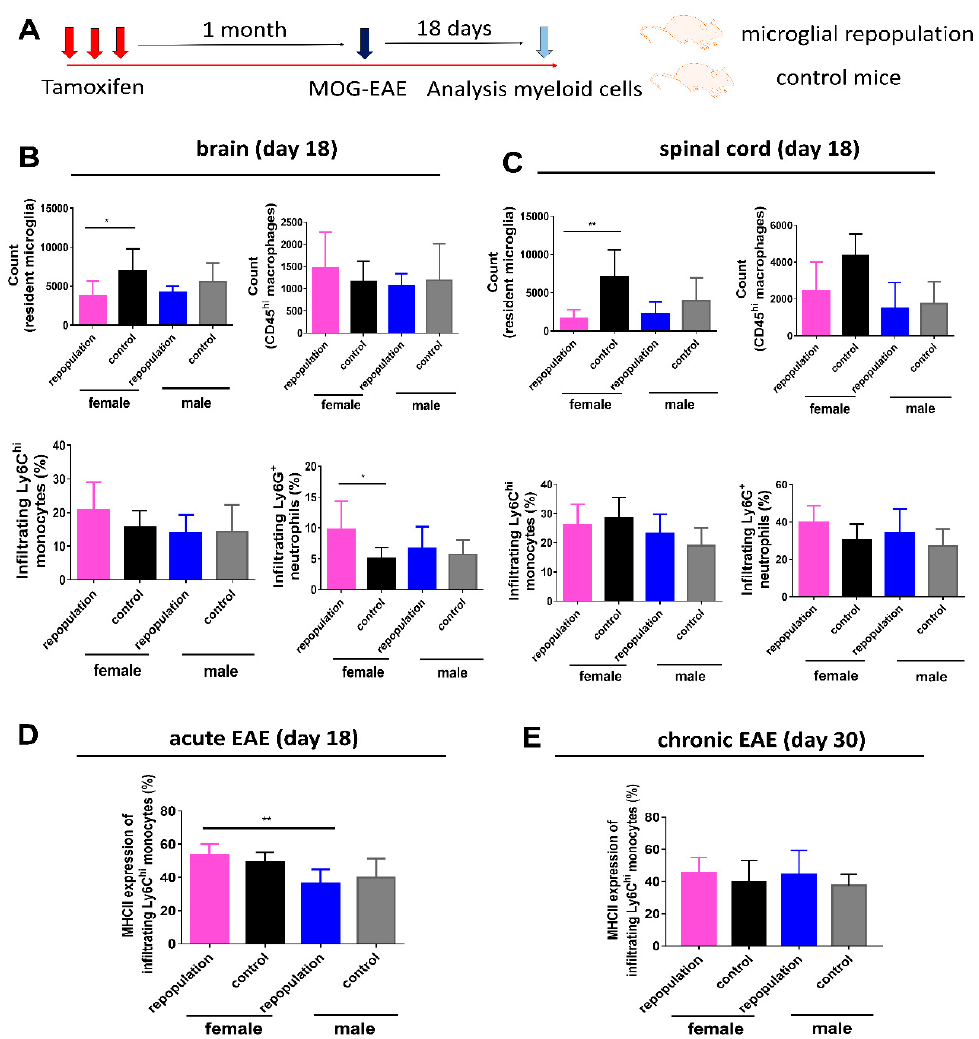
Figure 5. Higher MHC II expression of infiltrating Ly6C hi monocytes during peak EAE in female microglia-repopulated mice ( A ) Schematic overview of the experimental design. One month after tamoxifen injections, EAE was induced by active immunization with MOG in Cx3cr1 CreER /+ Rosa26 DTA /+ mice with newly repopulated microglia and Cx3cr1 CreER /+ mice with resident microglia (both male and female mice). Brain and spinal cord tissues were dissected on day 18 post-immunization (acute EAE period). Myeloid cell subset analysis in the brain ( B ) and spinal cord tissues ( C ) of Cx3cr1 CreER /+ Rosa26 DTA /+ mice and Cx3cr1 CreER /+ mice were performed using flow cytometry during the acute EAE disease course. MHC II expression (%) of infiltrating Ly6C hi monocytes was higher in the female repopulated microglia group than in the male repopulated group during the acute EAE period ( D ), while significant di ff erence was not evident during the chronic EAE period ( E ). Acute EAE experiment: n = 6 mice / group in female repopulation, female control and male repopulation groups, and n = 7 mice in male control group. Chronic EAE experiment: n = 5 mice in each group. Statistical significance is indicated as * p < 0.05 and ** p <